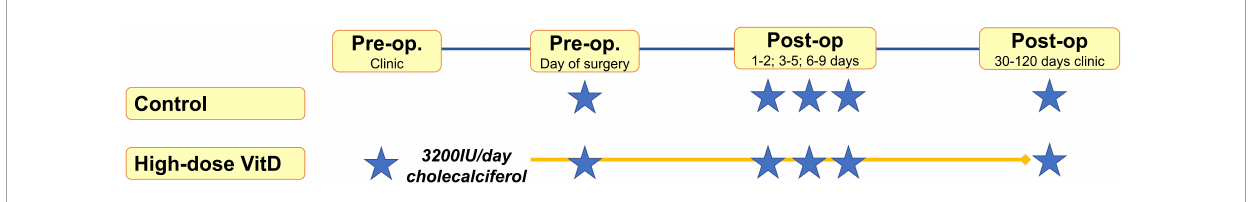
FIGURE1 May-adjusted peri-operative 25-hydroxy vitamin D (25OHD) in supplemented and control groups Median 25OHD levels charted in nmol/l. Number of patients in each group and P-values given. False discovery rate (FDR) P-value given adjusted in mixed-effects model for gender, age, body mass index (BMI), cancer site, operative approach, and American Joint Committee on Cancer stage (AJCC).